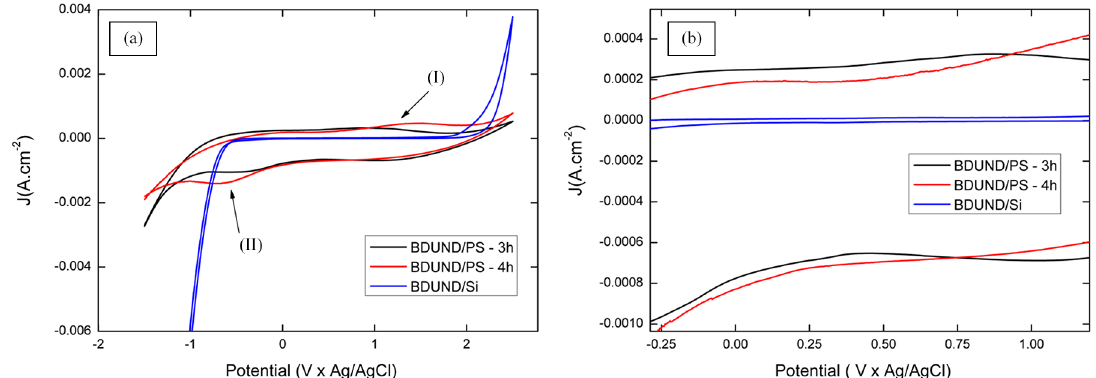
Figure 7. (a) Work potential windows of BDUND/PS grown for 3h and 4h, and of a BDUND/Si sample, (b) Zoom view of the work potential